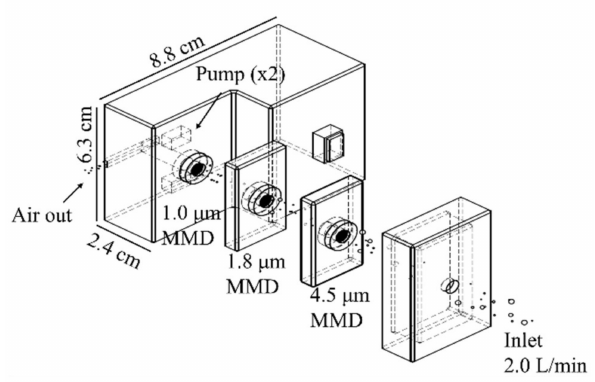
Figure 2. Schematic diagram showing the setup of the suction devices using stacked MMD sensors to capture aerosol particles according to size. A low-flow-rate air suction device used 4.5 µ m, 1.8 µ m, and 1.0 µ m MMDs for collection of PM10, PM2.5, and PM1.0,